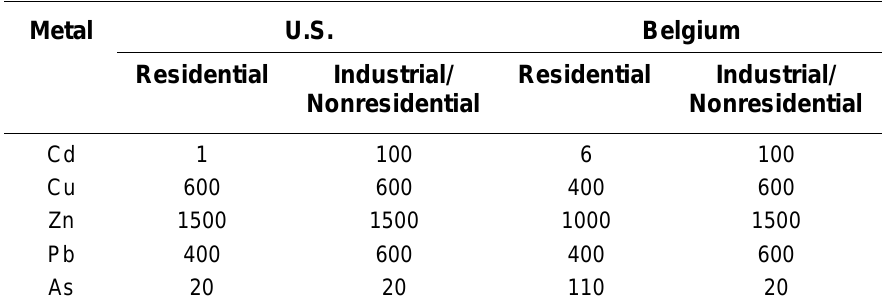
Clean-Up Values for Some Metals (mg kg –1 Standard Soil) in Residential and Industrial/Nonresidential Areas in U.S. and Belgium[5,31]